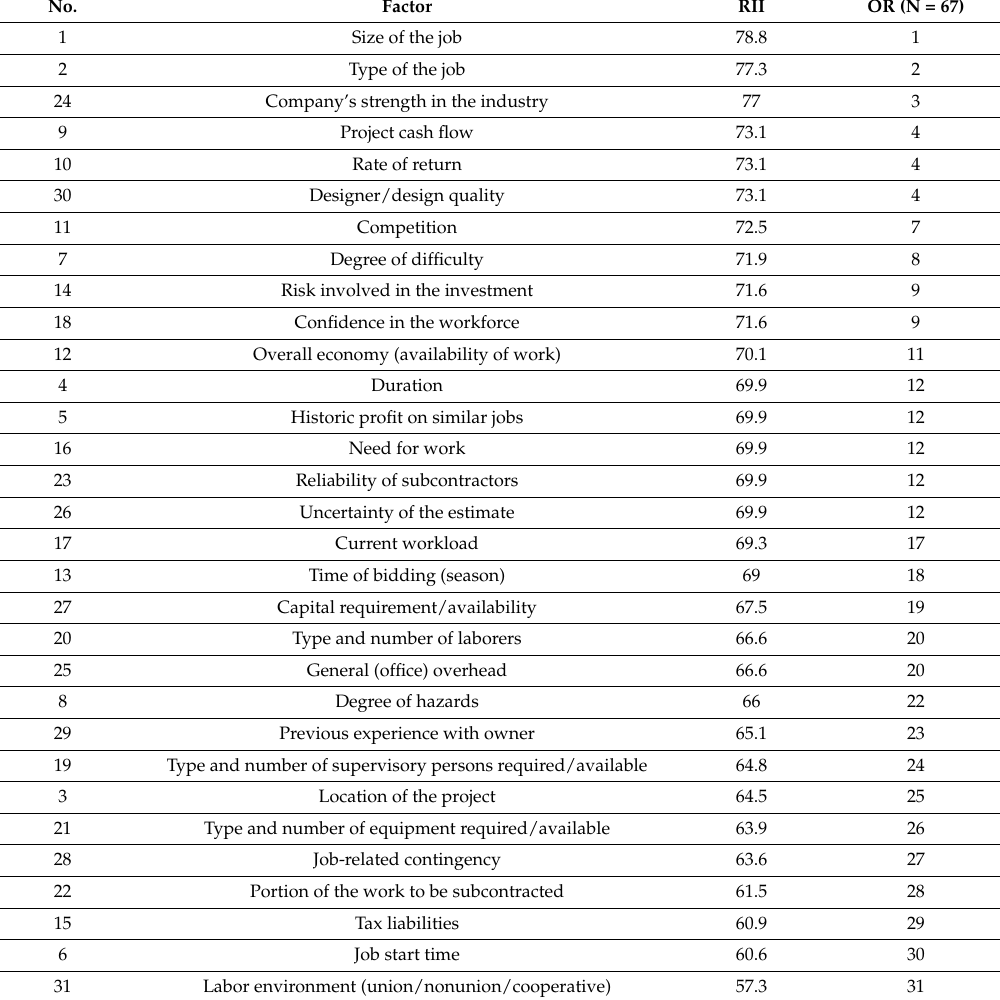
Table 2. Factors arranged according to their respective